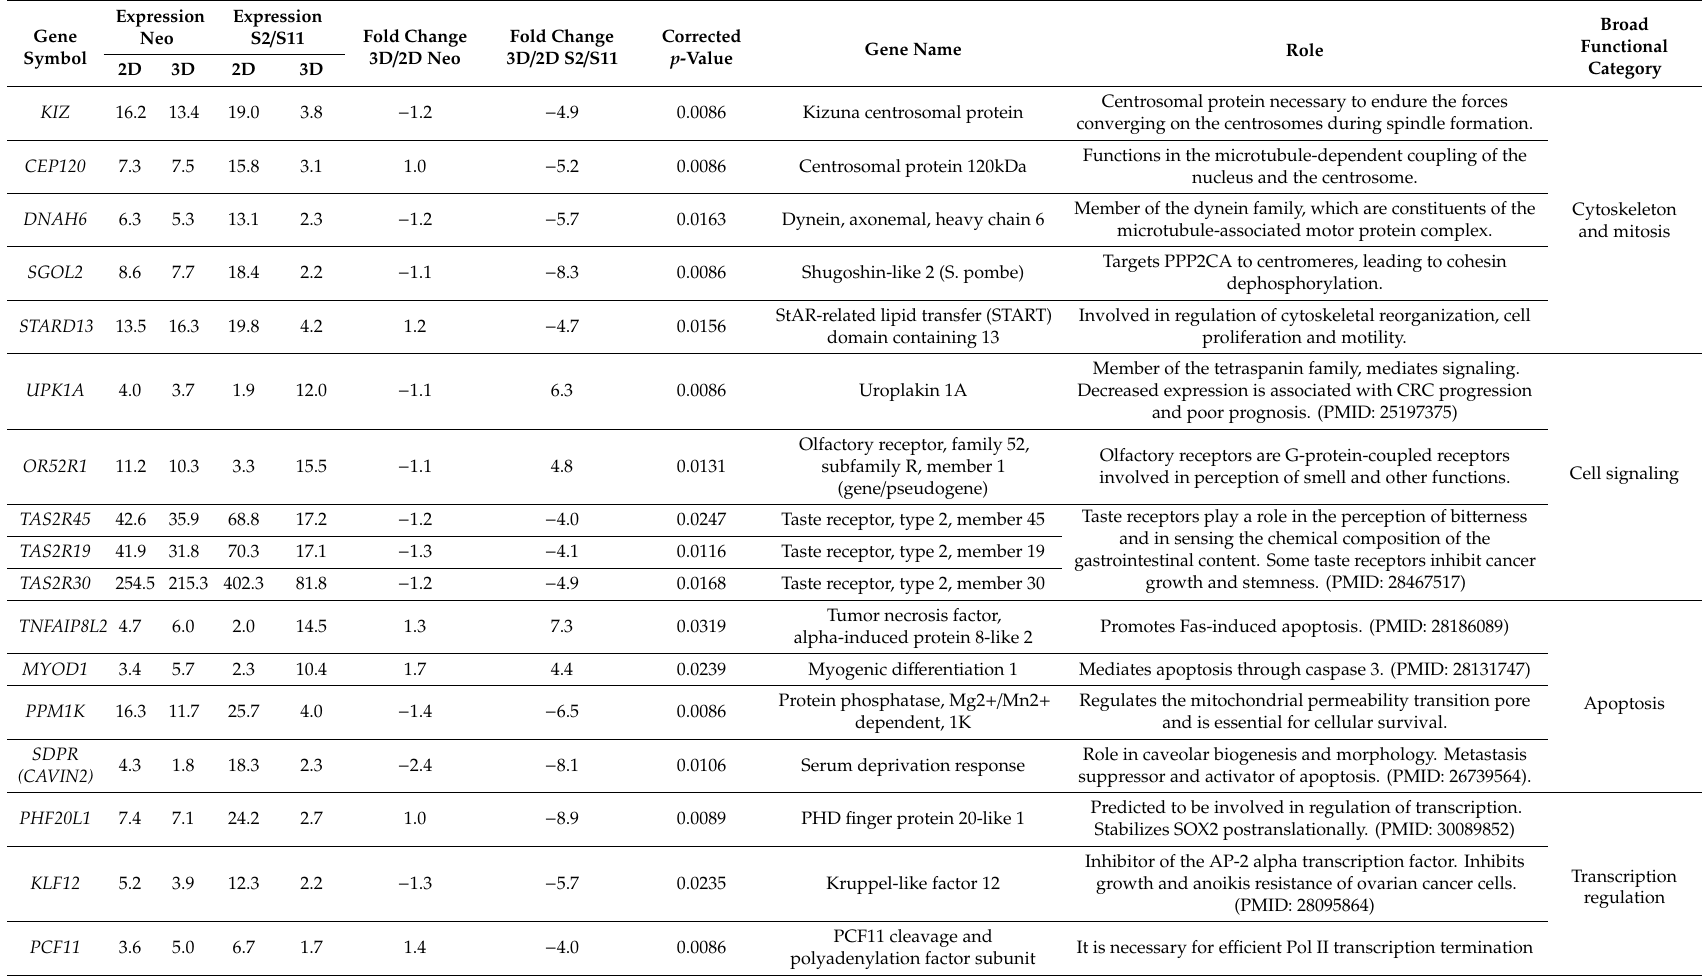
Table 5. Genes highly modulated by 3D only in B4GALNT2-expressing LS174T cells (clones S2 /